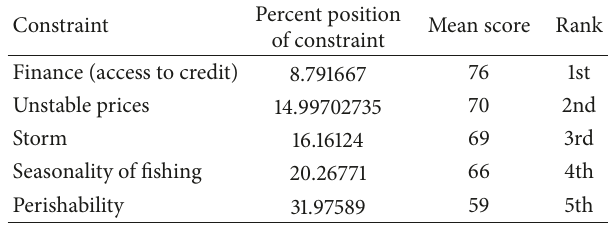
Table 4: Constraints ranked by the artisanal fishers in Pru